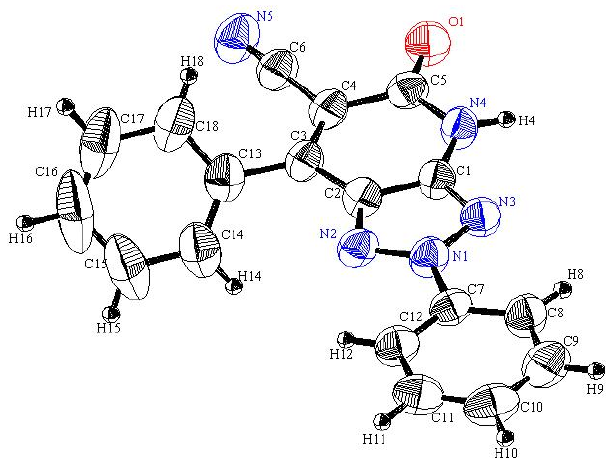
Figure 1. ORTEP plot of the x-ray crystallographic data determined for 5a . Crystallo- graphic data have been deposited with the Cambridge Crystallographic Data Centre as supplementary publication number CCDC 804721 [22].